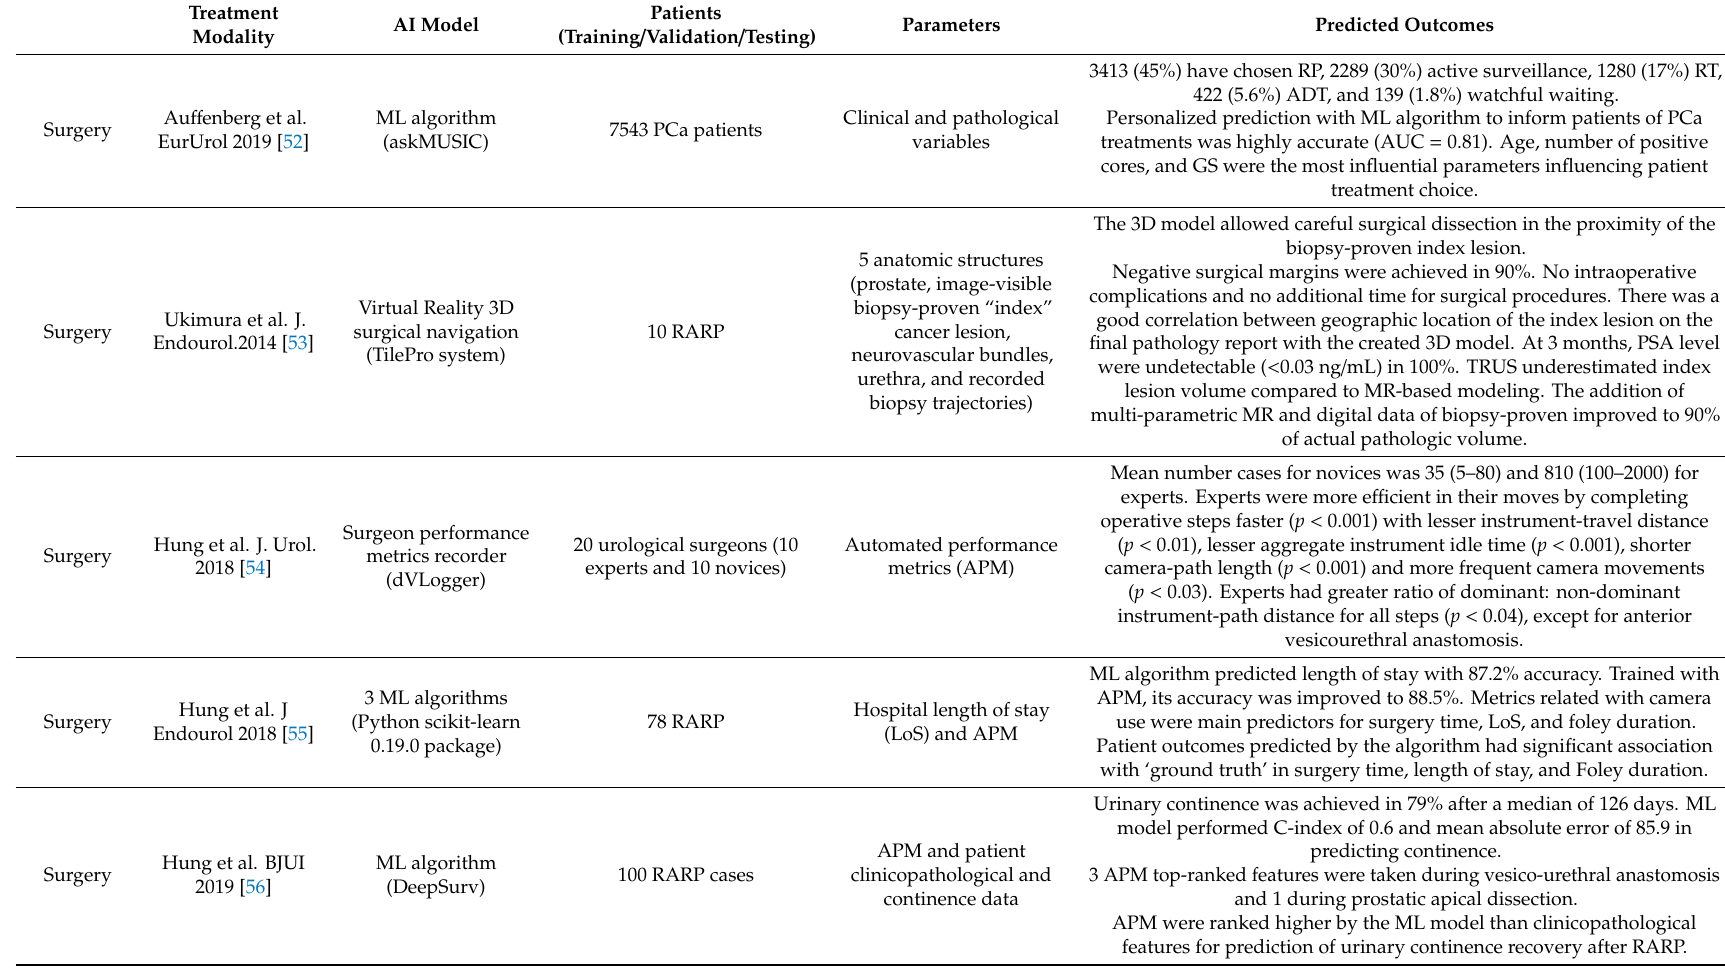
Table 3. Summary of the characteristics of studies reporting on Artificial Intelligence (AI) in the prostate cancer treatment and